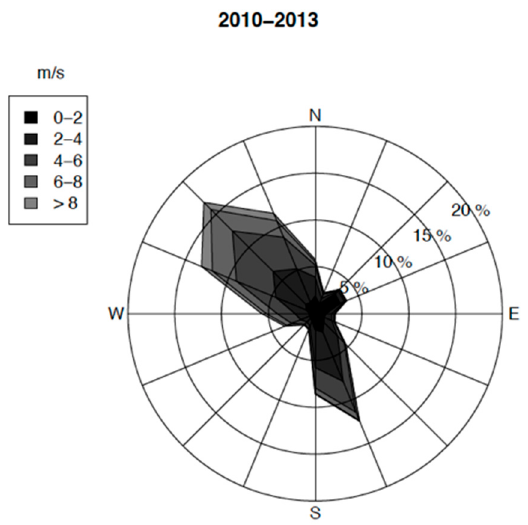
Figure 3. Distribution of the wind directions throughout the four years experiment. The wind rose indicates the occurrence of wind speeds for 16 wind directions.